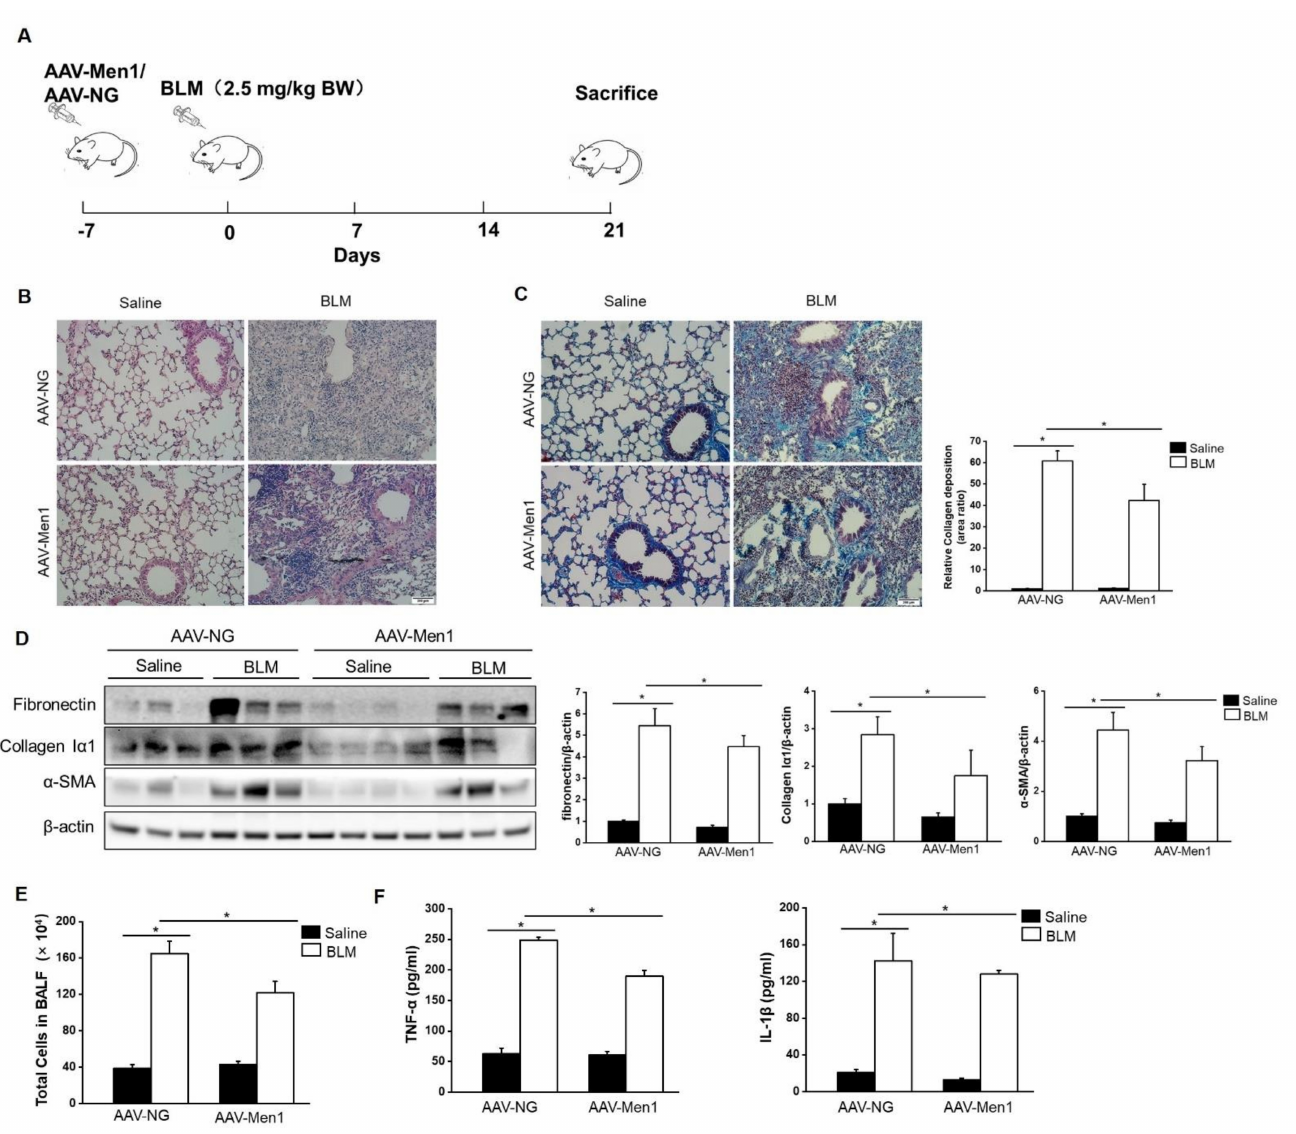
Figure 2. Men1 overexpression inhibited BLM—induced pulmonary fibrogenesis. ( A ) Schematic showing the procedure of animal experiments. ( B ) H&E staining of lung tissues. Scale bar: 200 µ m. ( C ) Masson staining of lung tissues. Collagen deposition was quantified by Image J software. Scale bar: 200 µ m. ( D ) The protein levels of fibronectin, collagen I α 1, and α -SMA in lung tissue were determined by Western blotting, and quantification was performed by Image J software. ( E ) Total cells of BALF were counted by hemocytometer. ( F ) Contents of TNF- α and IL-1 β in BALF were estimated by ELISA. n = 6 for Saline groups and n = 7 for BLM groups. * p <